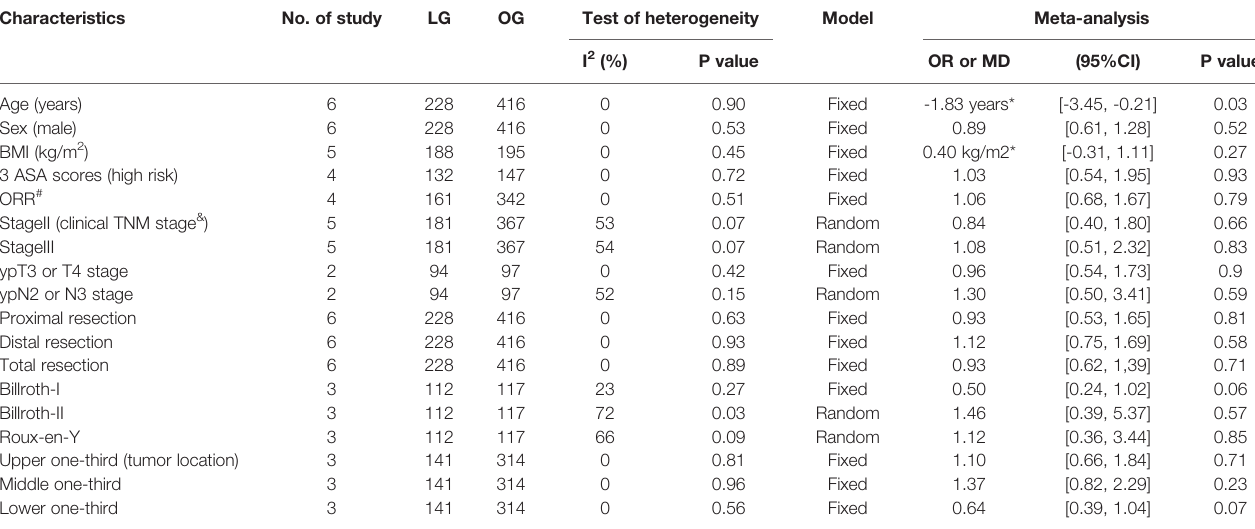
TABLE 2 | The meta-analysis of clinical features of AGC patients following NAC between LG group and OG group. Characteristics